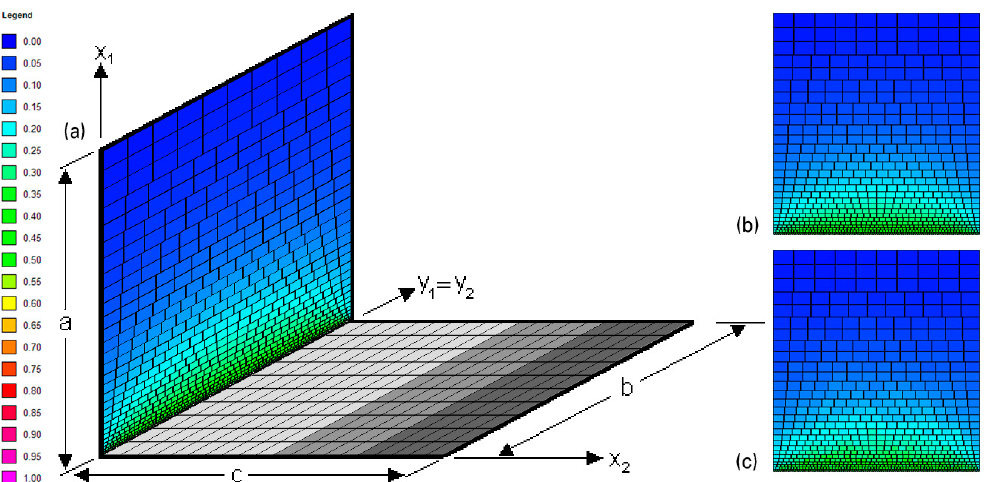
Figure 10. Application of NUGP and NUGMC approaches for the case in Figure 4c. The horizontal surface is non-uniform reflecting, the vertical surface is receiving. The coloured part visualises the VF from the center of each receiving cell to all emitting surface: ( a ) case with two surfaces with common edge; ( b ) grid for NUGP; and ( c ) grid for NUGMC.